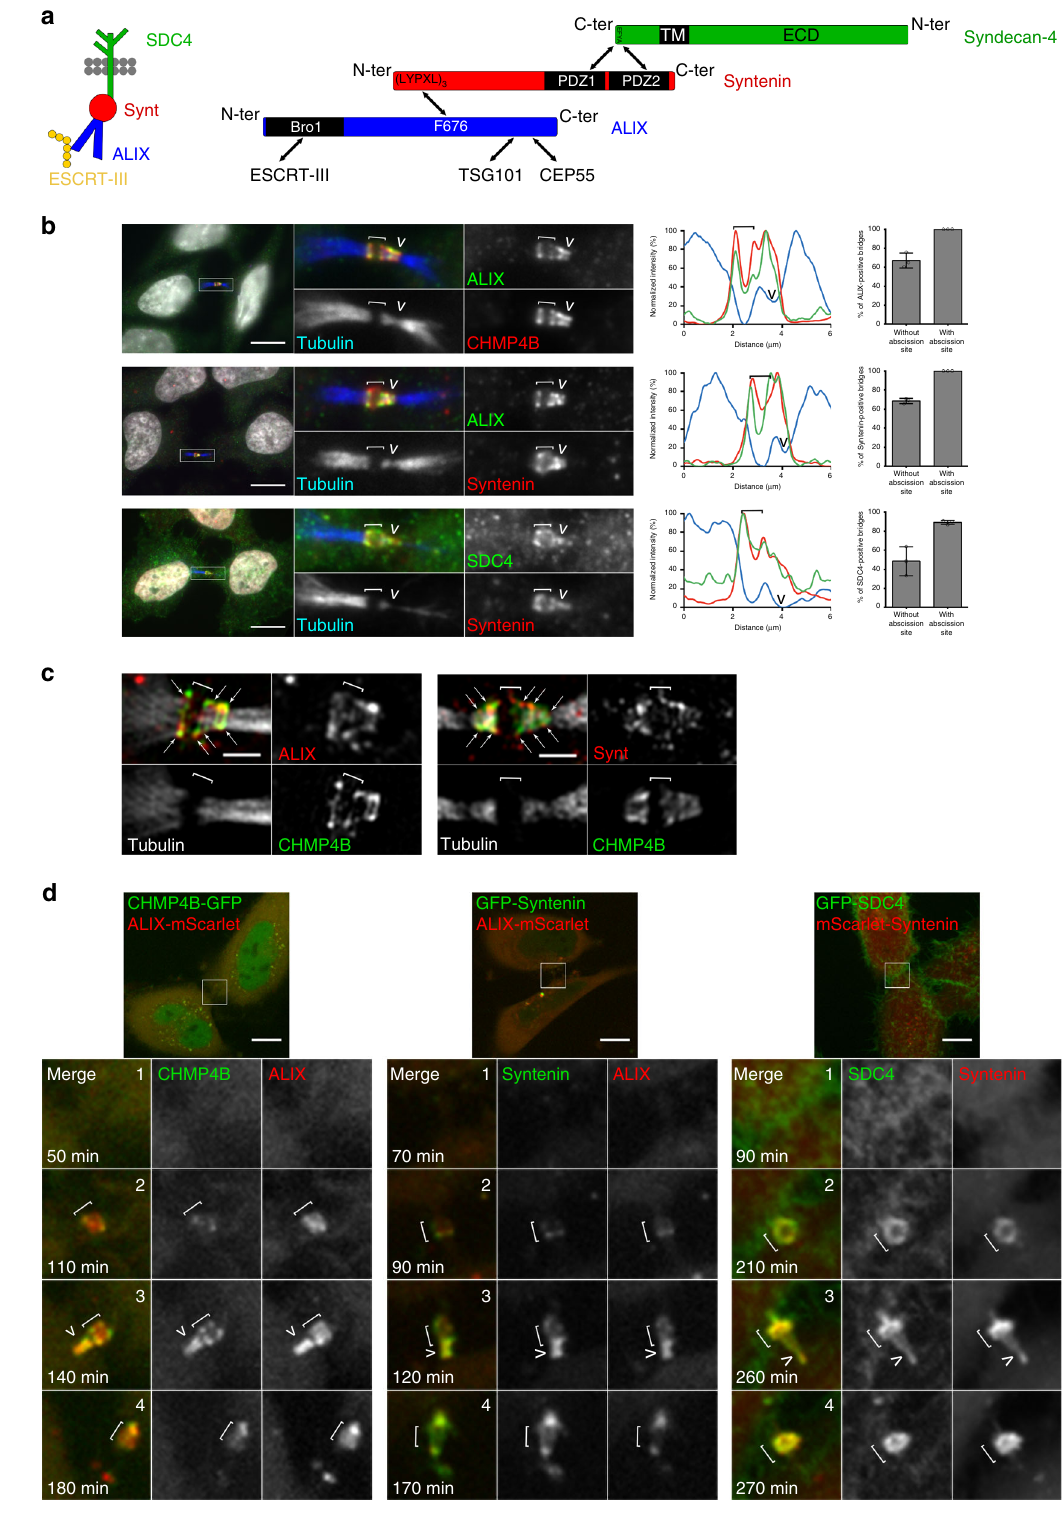
transmembrane and cytosolic domains) was properly recruited, indicating that the extracellular domain is dispensable for syndecan-4 localization at the midbody or at the abscission site (Fig. 3f). These results indicate that syntenin and its interaction with syndecan-4 are necessary for syndecan-4 localization at the bridge. Functionally, depletion of either ALIX, syntenin or